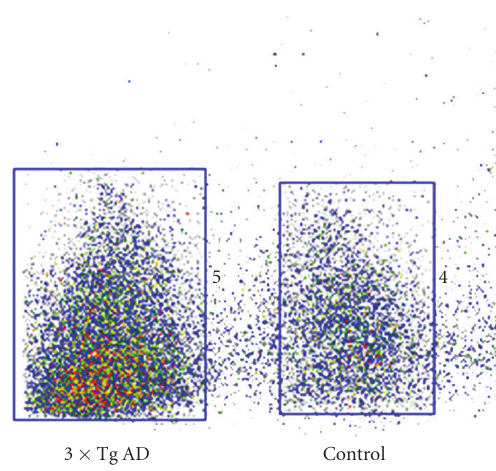
Figure 6: 125 ICQ BCA NPs triple transgenic mouse model (mice aged 12 mo; 1 hour postinjection).